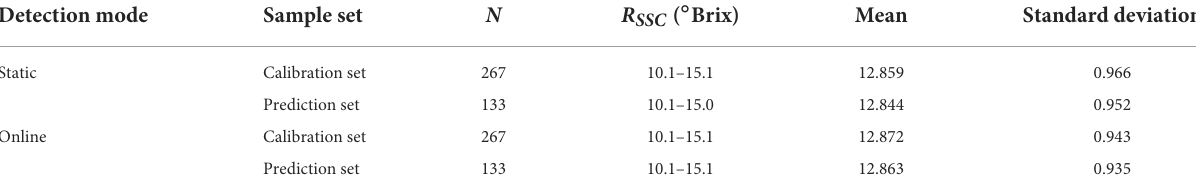
TABLE 1 Statistical information of the experimental samples.